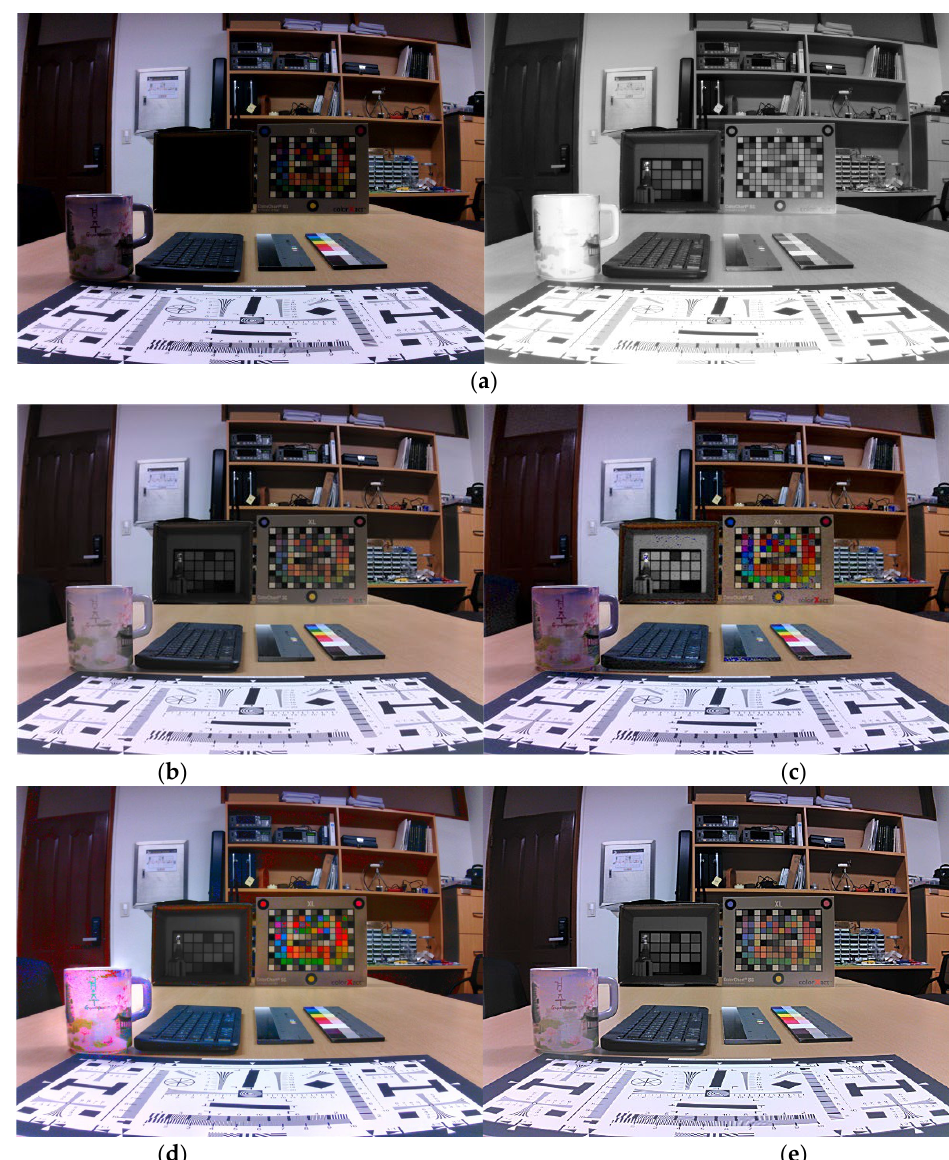
Figure 15. Daytime input and result images (3): ( a ) visible-light image and near-infrared image, ( b ) Densefuse method result, ( c ) Vanmali method result, ( d ) PCA method result, ( e ) proposed method result.